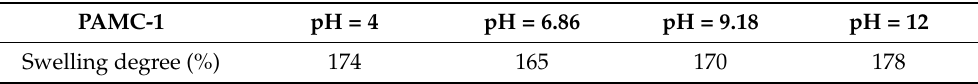
Table 3. Equilibrium swelling degree of PAMC-1 in NaCl solutions with different pH values.